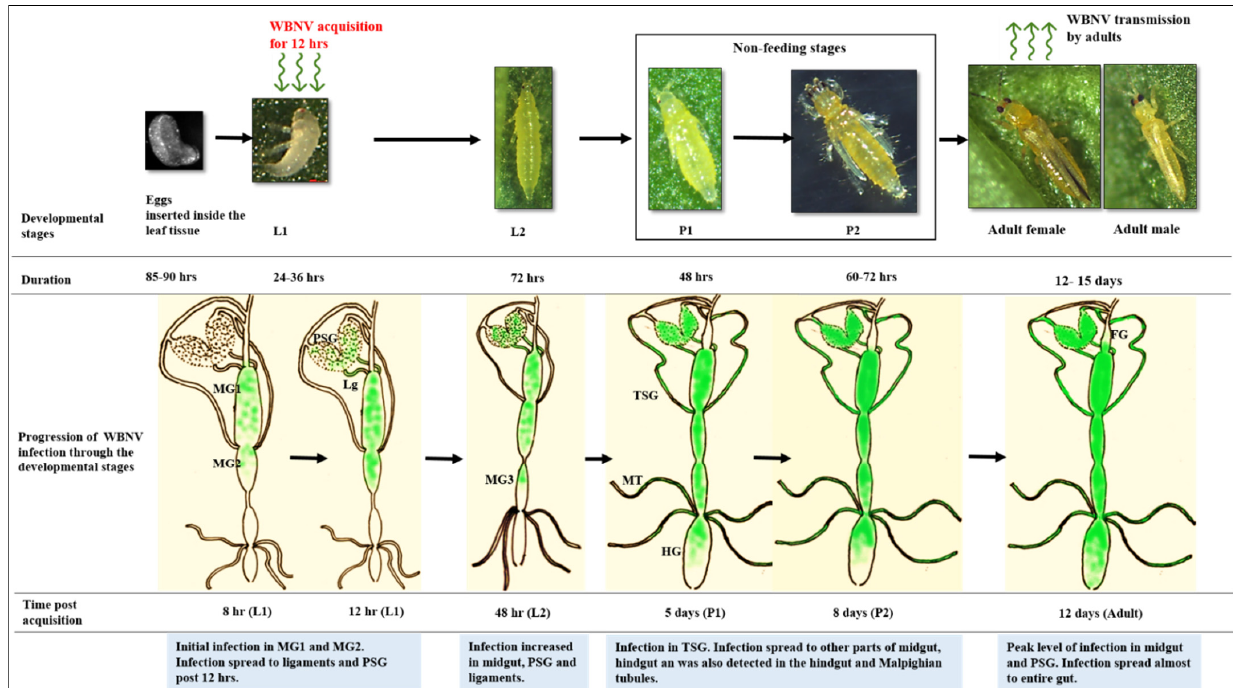
Figure 10. A schematic representation of WBNV dynamics from egg to adult stages of Thrips palmi . FG—foregut; MG1— midgut 1; MG2—midgut 2; MG3—midgut 3; HG—hindgut; PSG—principal salivary gland; TSG—tubular salivary gland; Lg—ligament; MT—Malpighian tubules. Microscopic kidney shaped eggs are inserted inside the leaf tissue under natural conditions. First instar larvae (L1) were exposed to WBNV for 12 h. The first infection of WBNV was observed in anterior midgut comprising MG1 and MG2. Infection spread to PSG from midgut through connecting ligaments 12 h post acquisition during late L1 stage. Infection increased in MG1, MG2, anterior portion of MG3, PSG, and ligaments in second instar larvae (L2) 48 h post acquisition. Infection in TSG was prominent in all samples during pupal stages (P1, P2). WBNV infection was also detected in the hindgut and Malpighian tubules 8 days post acquisition. Peak level of infection in PSG and midgut was observed during adult stage. Infection spread almost through the entire gut 12 days post acquisition.